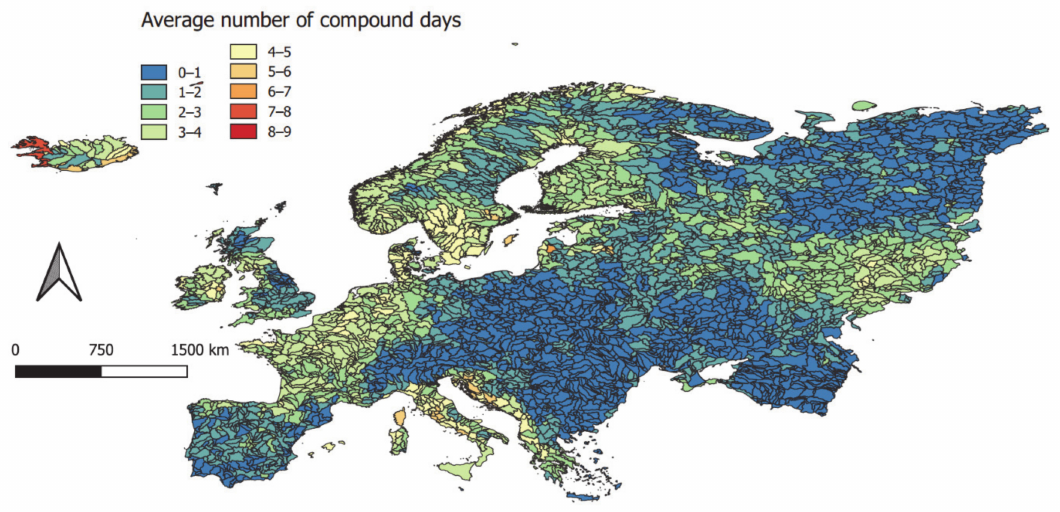
Figure 2. Mean annual number of days with a compound occurrence of drought and extreme heat according to the basic case and 365 days used as the antecedent precipitation ( N